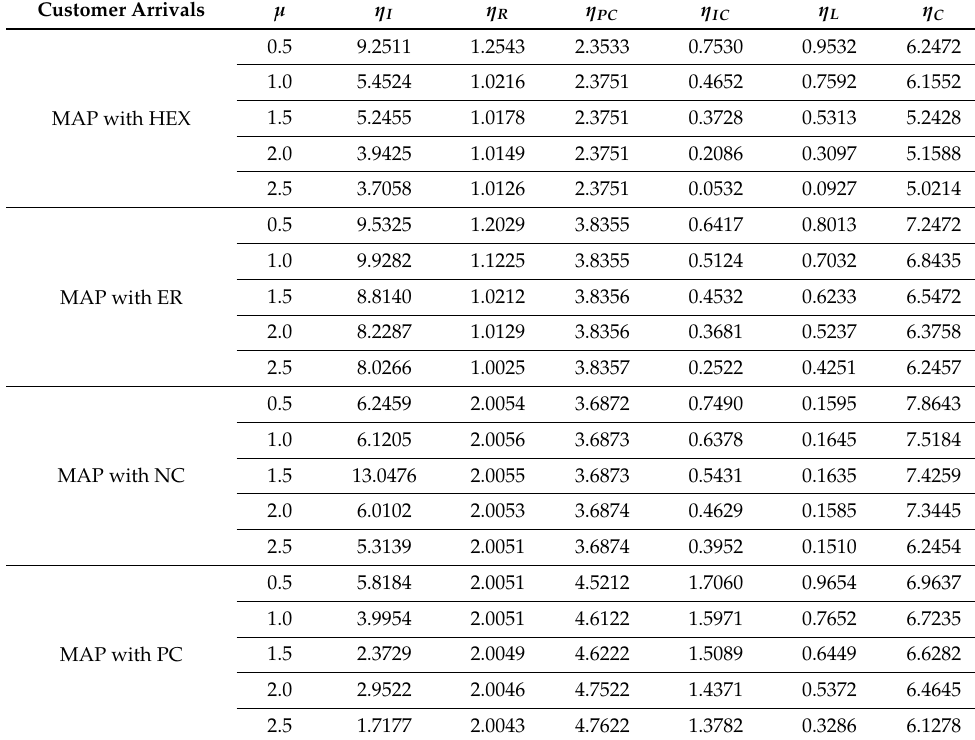
Table 6. Ramification of MAP with ER, NC and PC for ( S , s , θ , β ) = (21, 7, 10.5,